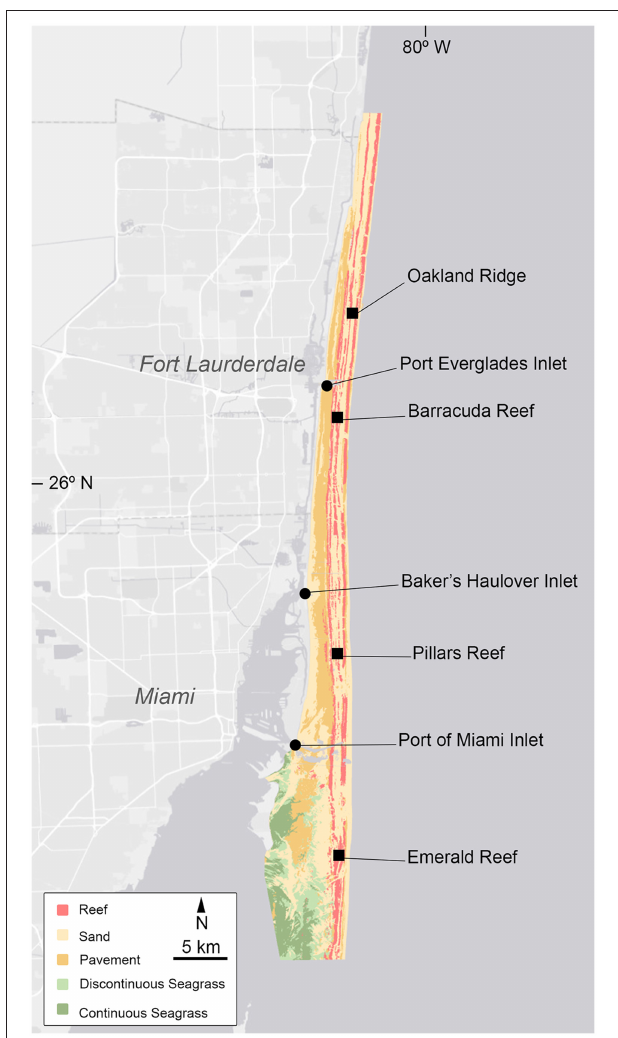
FIGURE 1 | Site map showing the four reef (squares) and three inlets (circles) sampling sites. Colors reflect the dominant benthic habitat type. GIS data obtained from Florida Fish and Wildlife Research Institute (FWRI). http:// research.myfwc.com.